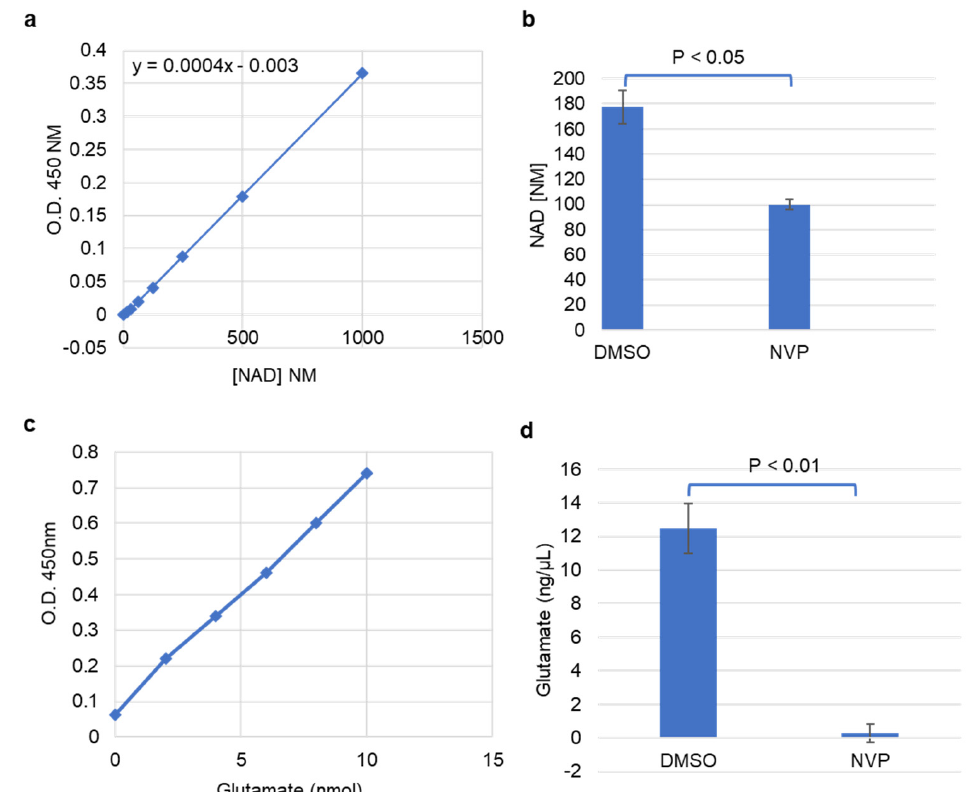
Figure 7. NAD+ and glutamate were reduced with NVP-BEZ235 treatment. ( a ) Absorbance of NAD+ concentrations at 450 nm. ( b ) The estimated concentration of NAD+ in control DMSO and 1 µ M NVP-BEZ235 samples. ( c ) Absorbance of glutamate concentrations at 450 nm. ( d ) The estimated concentration of glutamate in DMSO and 1 µ M NVP-BEZ235-treated samples. The error bars represent the standard deviation of the samples. Significance was determined by Student’s t-test.